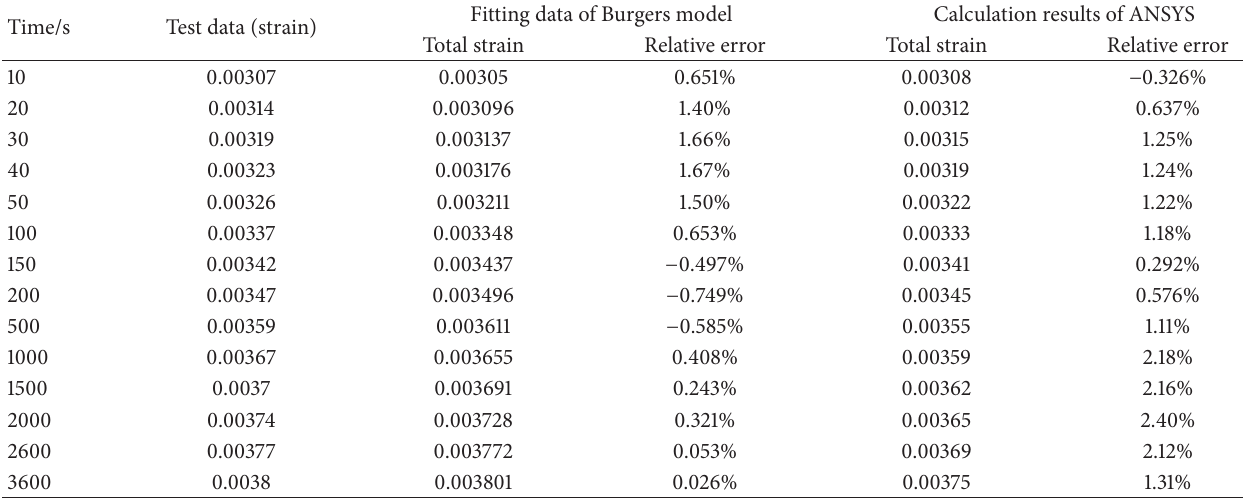
Table 3: Compared with the result of creep test, fitting data, and ANSYS